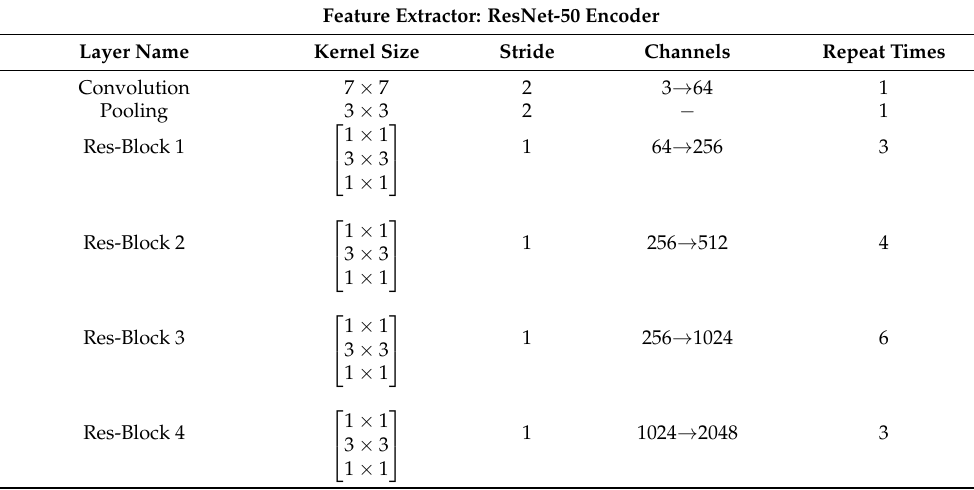
Table 6. The architecture of the feature extractor in our color identification model.